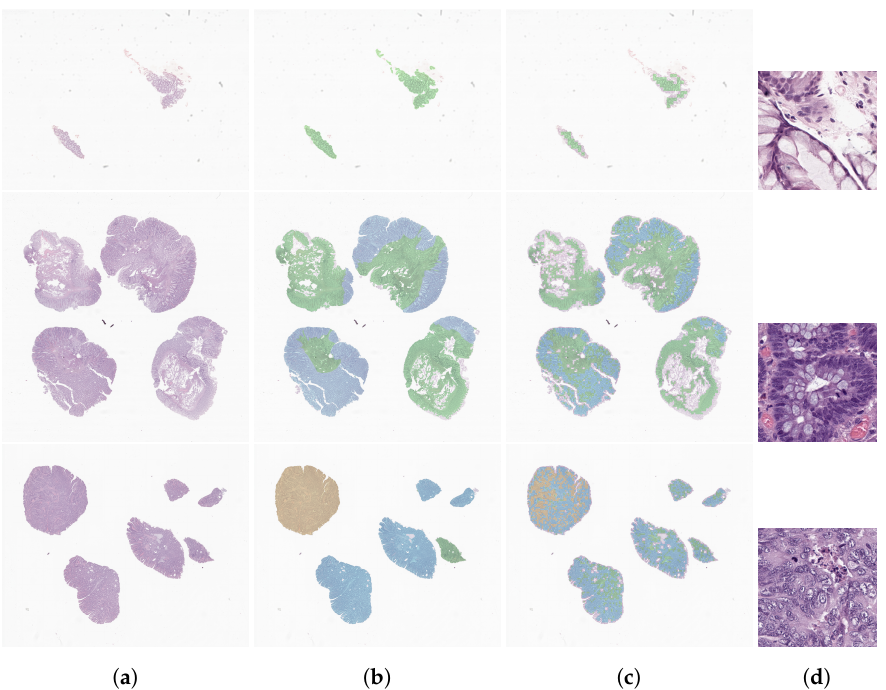
Figure 7. Examples of a model prediction map for each class, from the annotated data subset: a non- neoplastic case ( top ), a low-grade lesion ( middle ) and a high-grade lesion ( bottom ). Each column has the slides examples ( a ), the ground-truth annotation ( b ), the map with the tile predictions ( c ) and the most relevant tile (512 × 512 px), with the worst clinical class ( d ). The non-neoplastic, low-grade and high-grade regions are represented in green, blue and yellow,